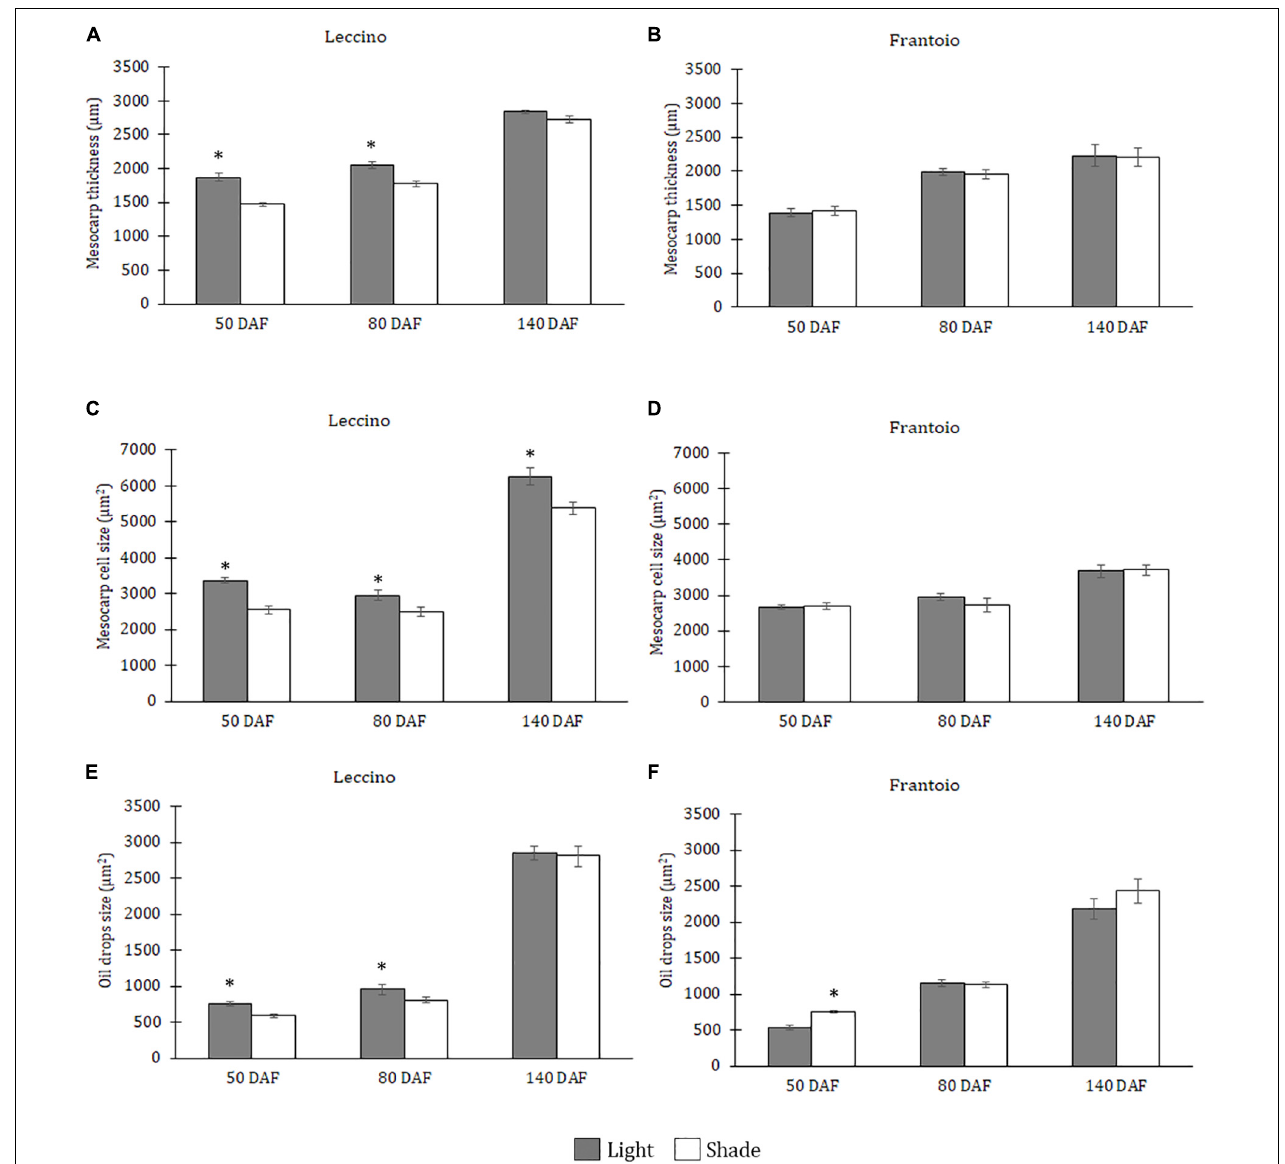
FIGURE 4 | Mesocarp thickness (A,B) , size of mesocarp cells (C,D) and oil drops (E,F) in Leccino (A,C,E) and Frantoio (B,D,F) shade and light fruits at different developmental stages. Data are reported as means ± standard errors per cultivar (Leccino and Frantoio) and light environment (light and shade). The asterisks indicate significant differences ( t -test) between treatments after Analysis of Variance within each date of sampling ( P <